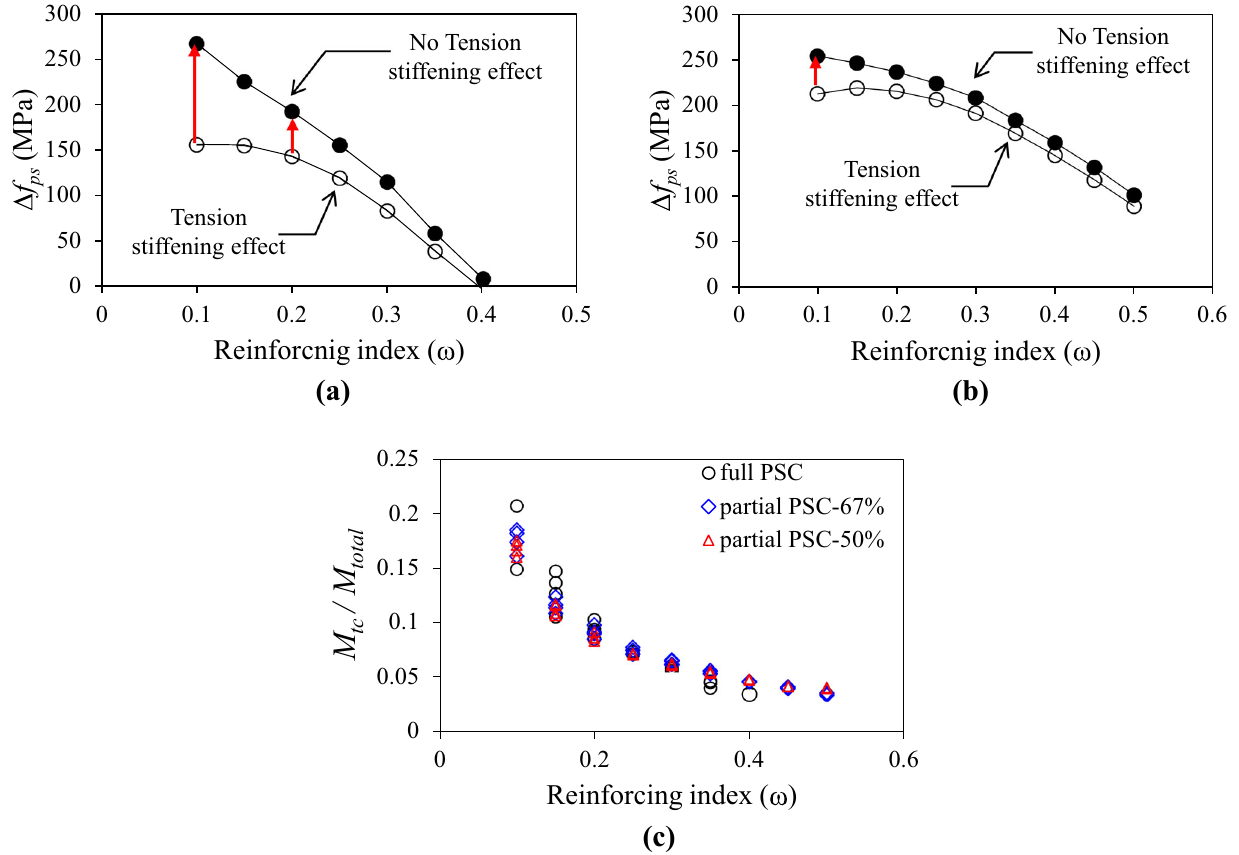
Fig. 11 Effect of tension stiffening on D f ps . a Full PSC sections, b Partial PSC sections (PPR = 50%), and c Contribution of concrete in tension zone to flexural strength.